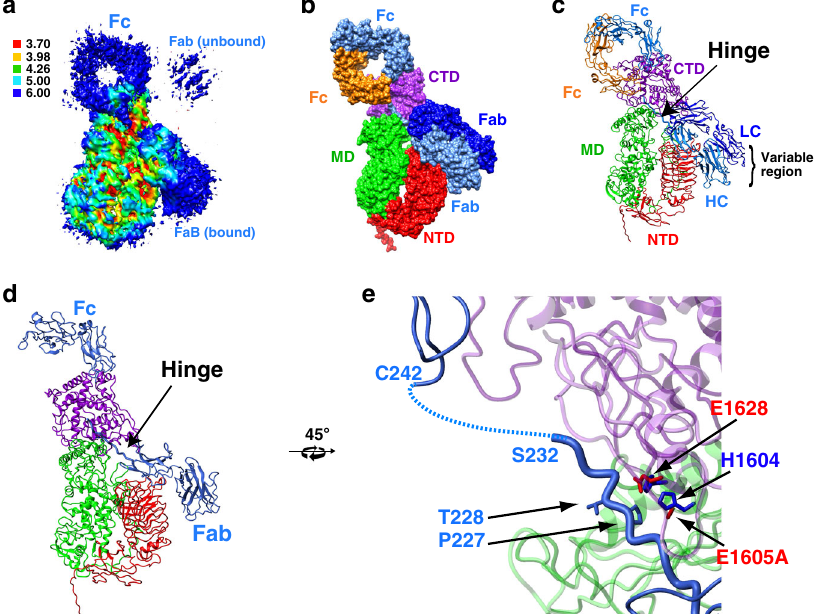
Fig. 2 Cryo-EM structure of the S. pneumoniae IgA1P/IgA1 complex. a 3D reconstruction of S. pneumoniae IgA1P-E1605A in complex with IgA1 is colored according to local resolution estimates (units in Å). The map was produced using Chimera 38 . b Surface representation of the IgA1P/IgA1 complex (PDB ID: 6XJA). The model comprises IgA1P residues 665 – 1963 (domains colored as in Fig. 1d), the IgA1 LC (dark blue), the IgA1 HC portion of the Fab (light blue), and the IgA1 Fc (orange and light blue for each HC monomer). c Ribbon structure of the IgA1P/IgA1 complex. The hinge connecting HC Fab and Fc is indicated by the arrow. d The IgA1P-IgA1 complex is shown with the bound HC monomer (both Fab and Fc). e Expansion of the active site with the bound IgA1 hinge. IgA1P catalytic residues are shown according to the colors in Fig. 1e. The scissile bond is between P227 and T228 (residues shown in blue).